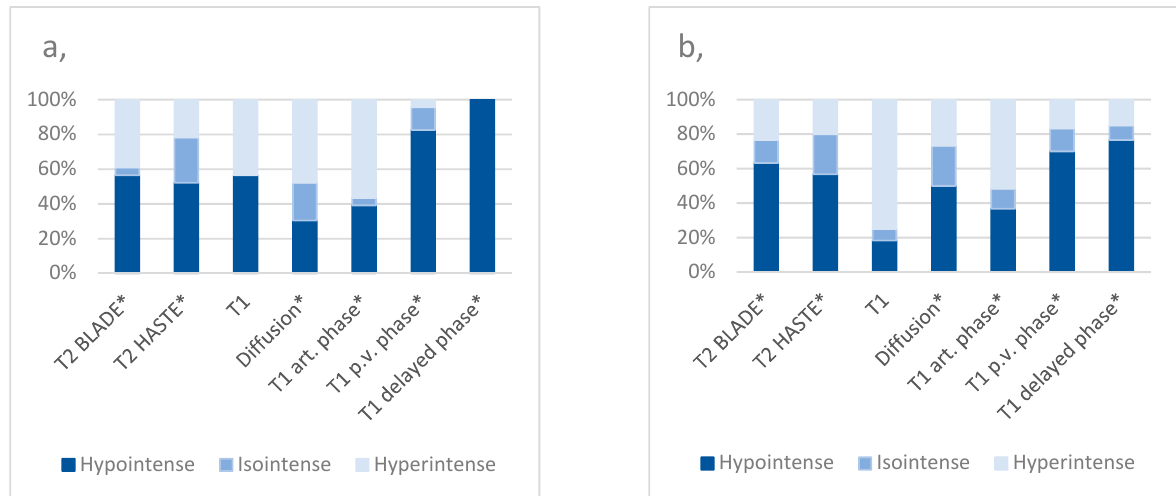
Figure 2. Proportions of signal characteristics in the central ablation zone of patients with a local tumor progression after IRE of an HCC ( a ) and of the reference group ( b ) * = contrast-enhanced; art. phase = arterial phase; p.v. phase = portal venous phase. Table 4. Diagnostic accuracy of MRI signal characteristics for the local tumor progression in the central part of the ablation area after IRE of HCC.